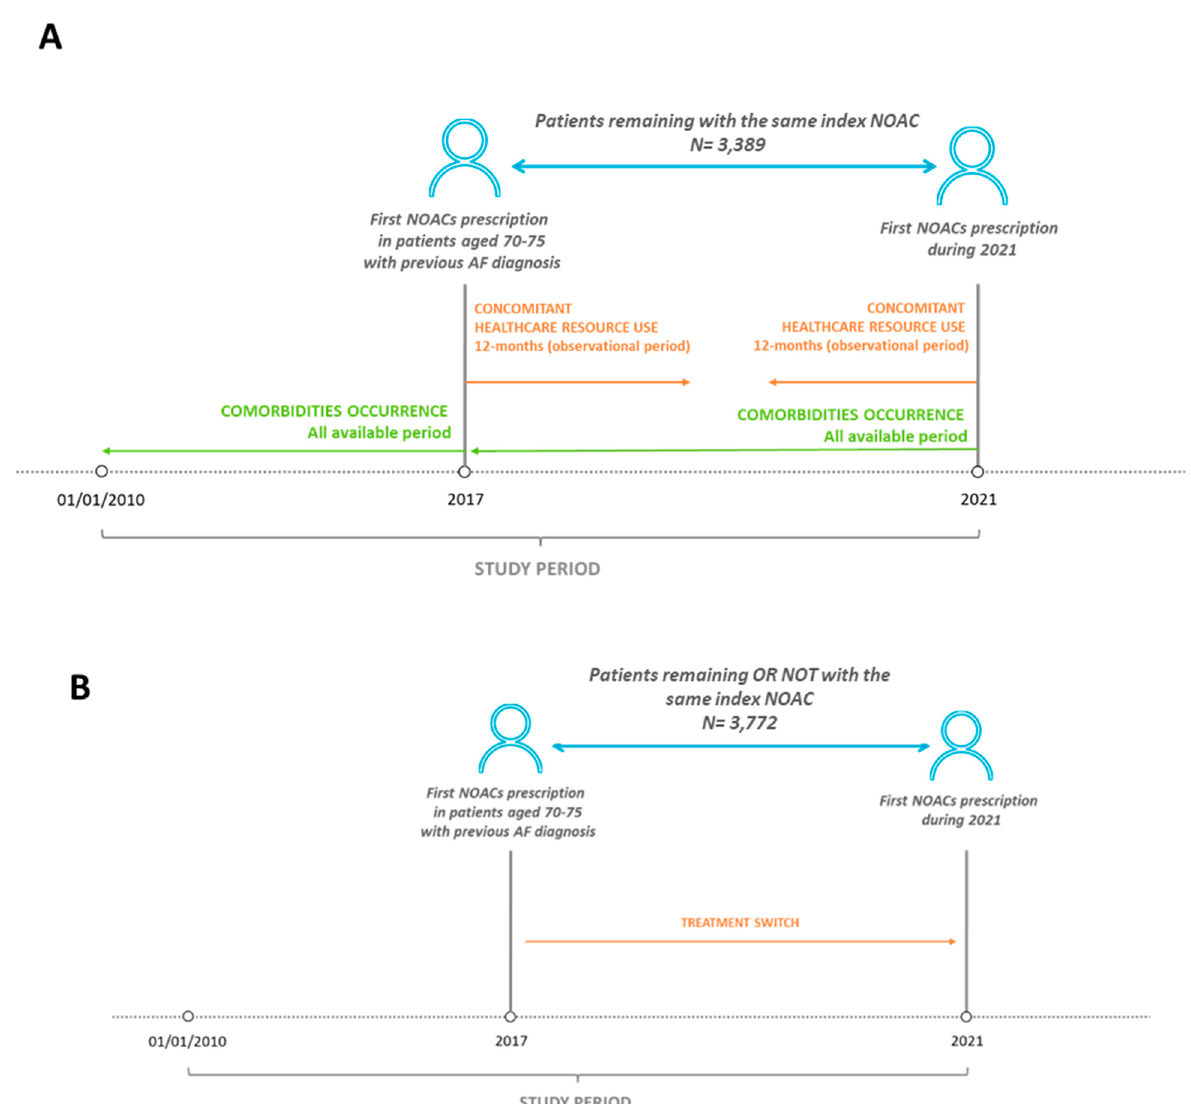
Figure 1. Schematic representation of study design. ( A ) For the analysis of comorbidities and healthcare resource consumption, patients prescribed with NOAC during 2017 and maintaining the same NOAC up to 2021 were included (N = 3389). ( B ) For the analysis of treatment switch, patients prescribed with NOAC during 2017 and remaining in treatment (with or without the same NOAC) up to 2021 were included (N = 3772).